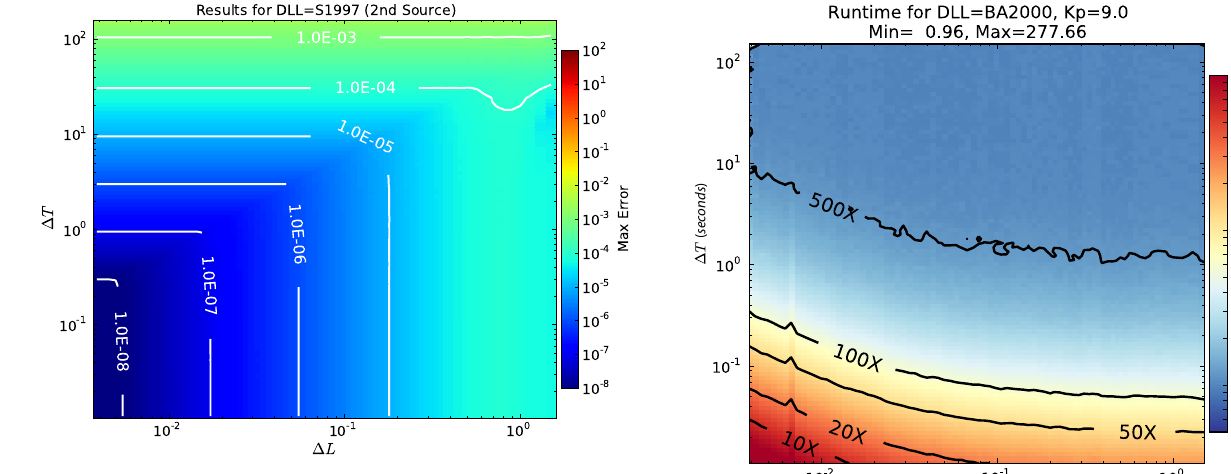
Fig. 10. Similar to Fig. 6 but showing results when the second, non-periodic manufactured solution is used (Eq. 9).